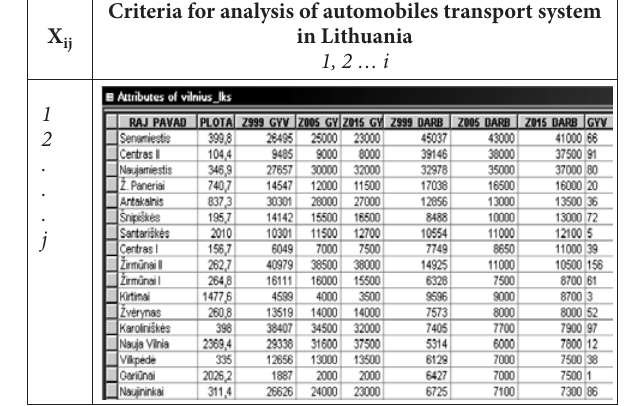
fig. 5. Socio-economic Vilnius TAZ